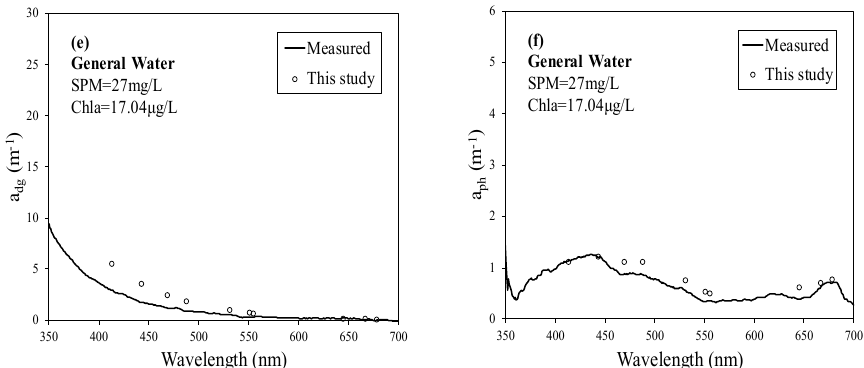
Figure 9. Comparison of derived and measured a ph and a dg of three different types of water: ( a )/( b ) turbid water, ( c )/( d ) eutrophic water, and ( e )/( f ) general water.